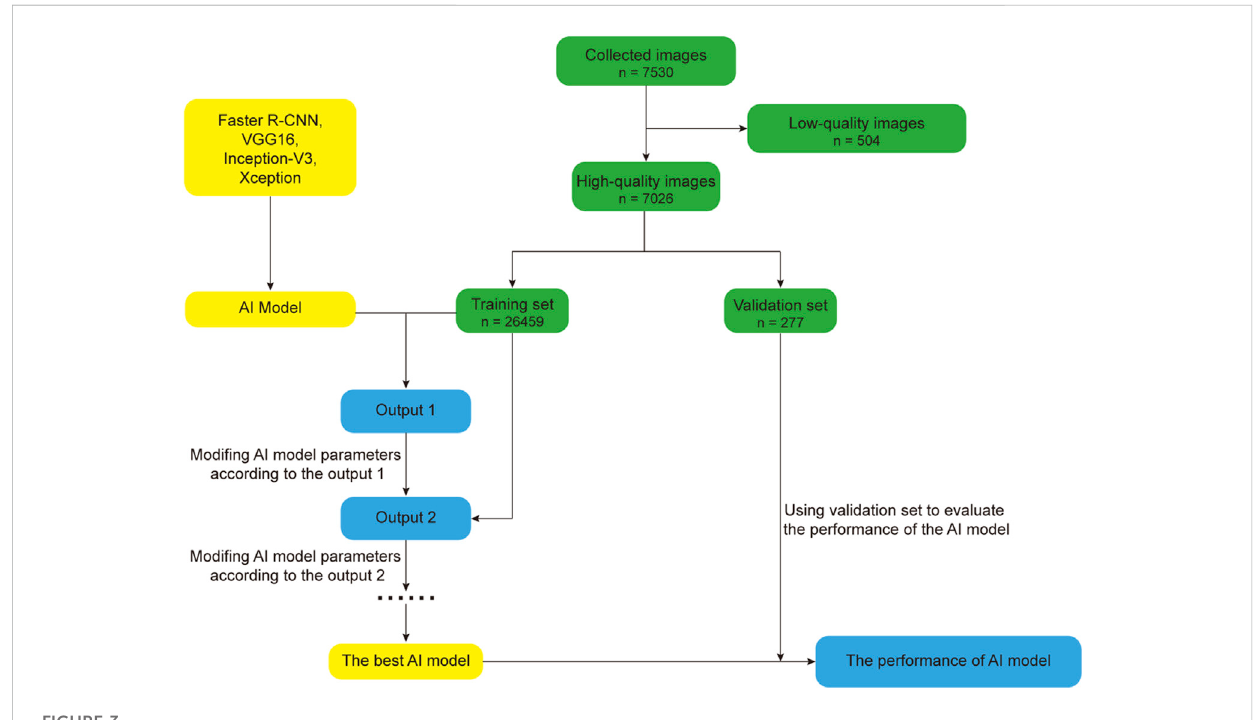
FIGURE 3 Basic fl ow chart illustrating AI model